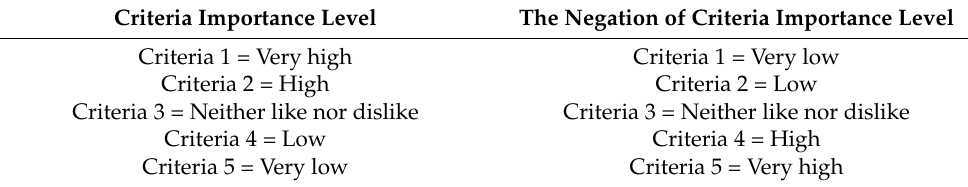
Table 3. Negation of criteria importance level [32].